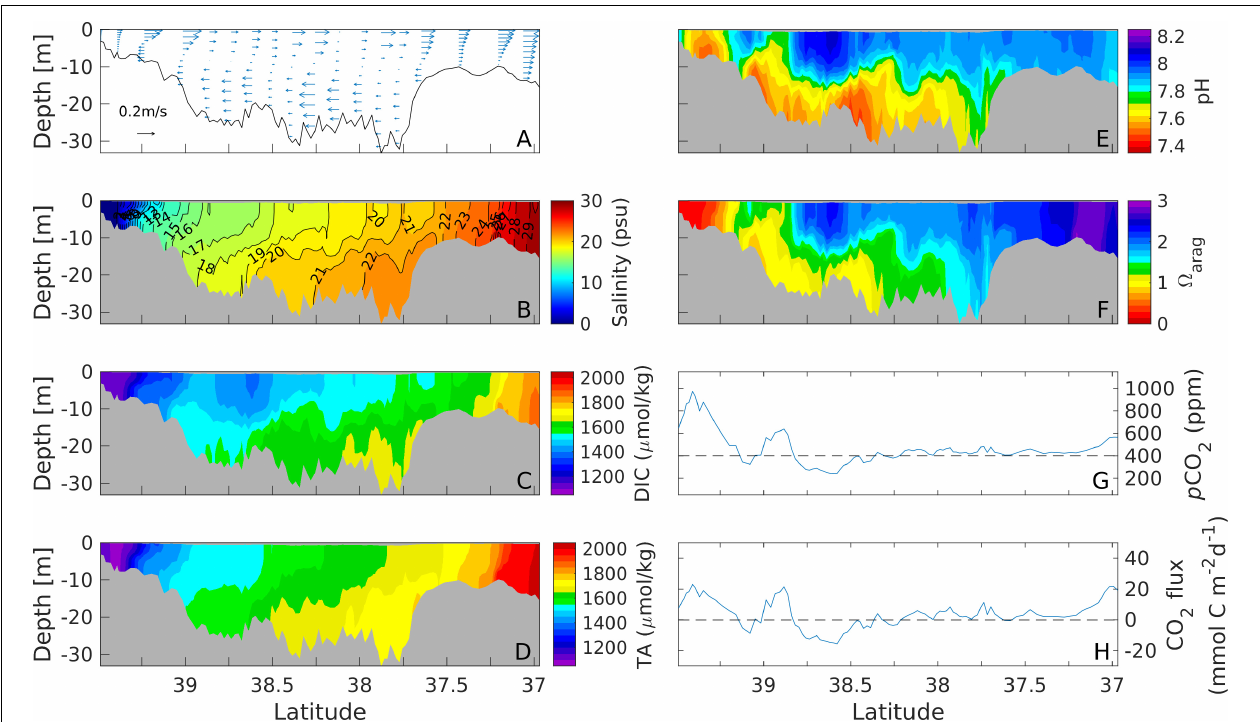
FIGURE 7 | Along channel distributions of subtidal current (A) , salinity (B) , DIC (C) , TA (D) , pH (E) , (cid:127) arag (F) , surface p CO 2 (G) and air-sea CO 2 flux (H) during a down-estuary wind event on 22–25 September, 2013.